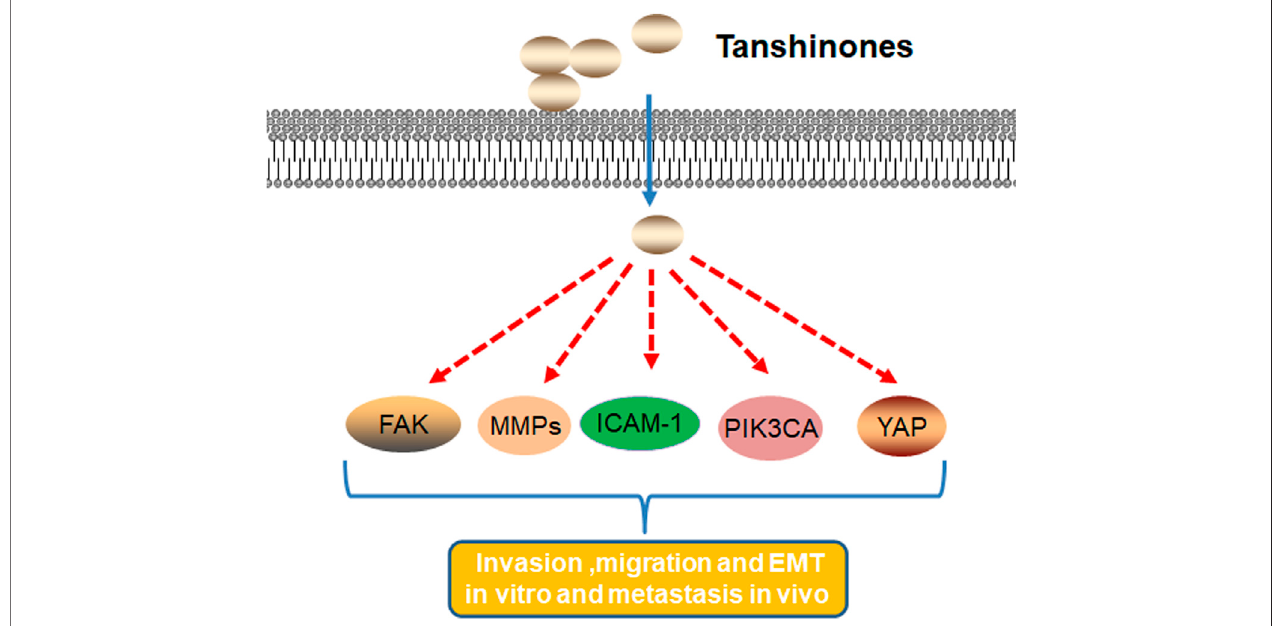
FIGURE 3 | Molecular mechanism of tanshinones inhibiting cell migration, invasion, metastasis, and EMT. Tanshinones inhibit protein expression in migration, invasion, metastasis, and EMT. FAK, focal adhesion kinase; MMPs, matrix metalloproteinases; ICAM-1, intercellular cell adhesion molecule-1; PIK3CA, phosphatidylinositol-4,5-bisphosphate 3-kinase catalytic subunit alpha; YAP, Yes1 associated transcriptional regulator.